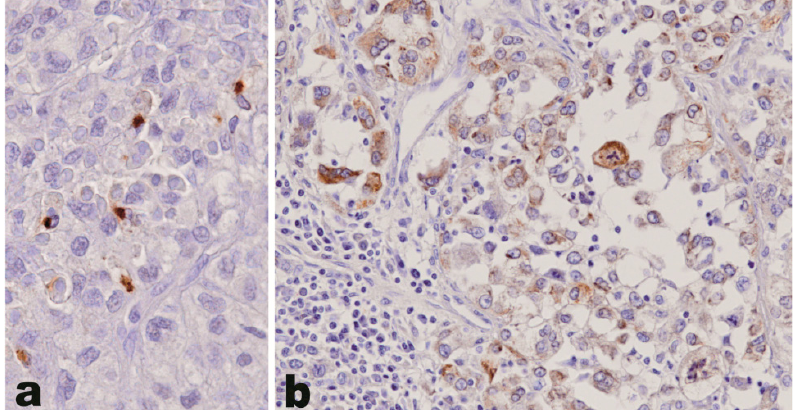
Figure 1. Osteopontin expression in adrenocortical carcinoma. The pattern of staining in adrenocortical carcinoma tumor cells is cytoplasmic, either with a peculiar dot-like paranuclear appearance ( a ) or diffuse within the cytoplasm ( b ). The intratumoral lymphocytes ( b , bottom left) are un-reactive (original magnification 400×).